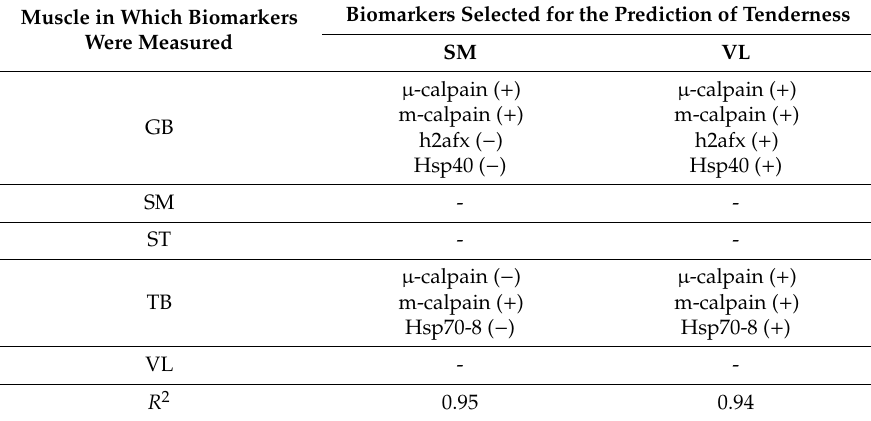
Table 4. Biomarkers selected of tenderness prediction.